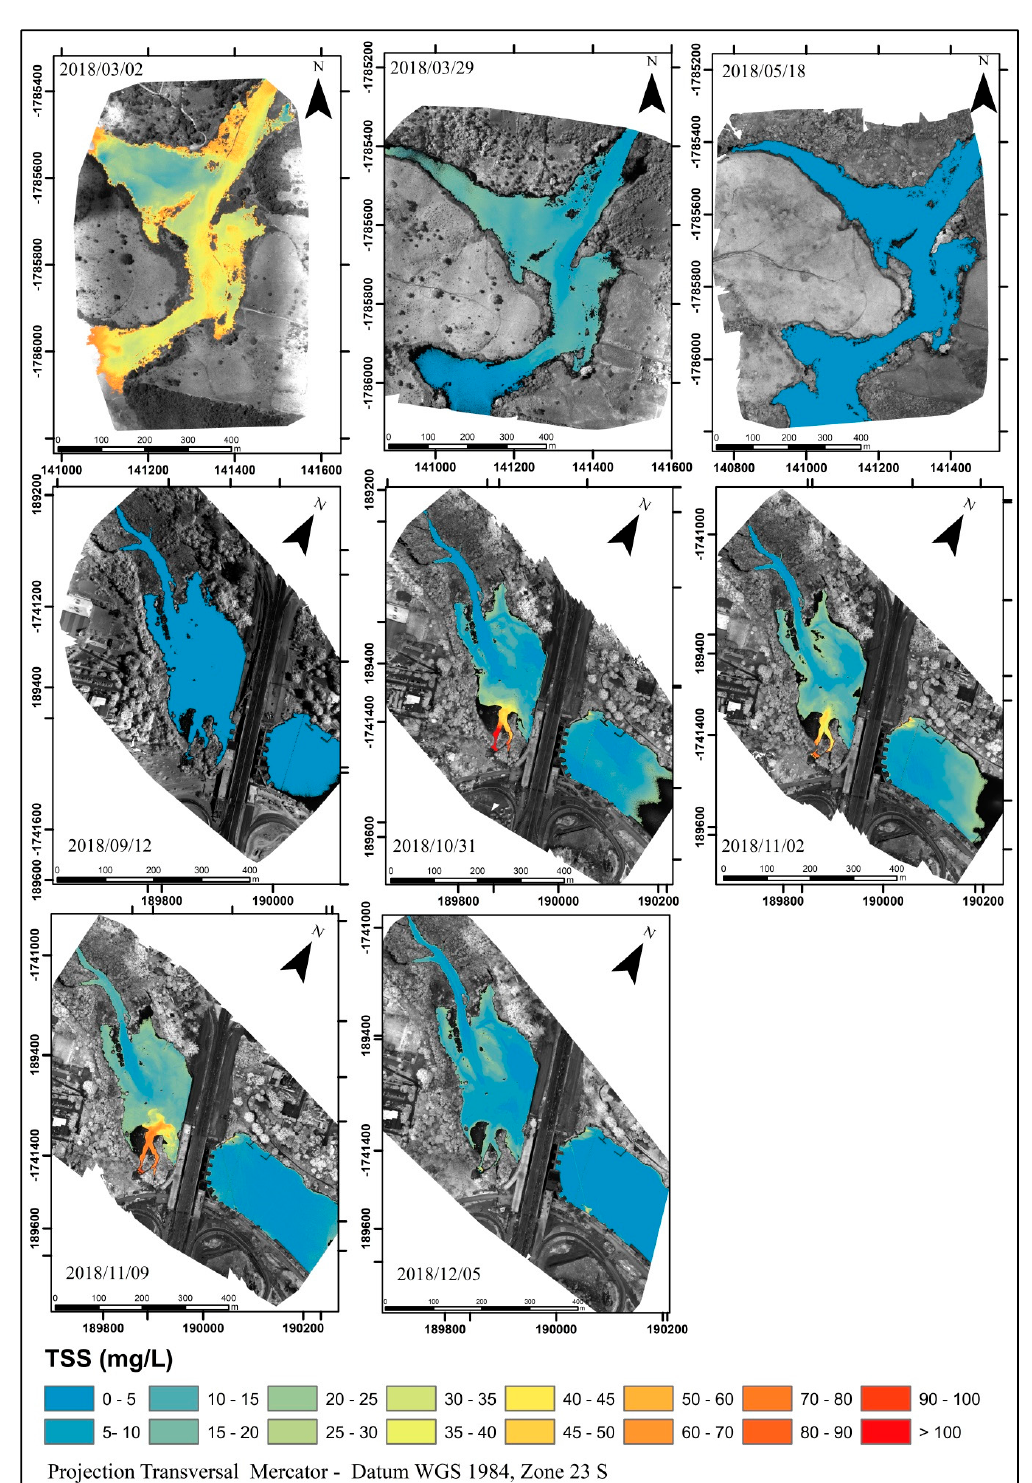
Figure 12. Time series of TSS concentration maps in the study areas, using model #1 (single NIR band).